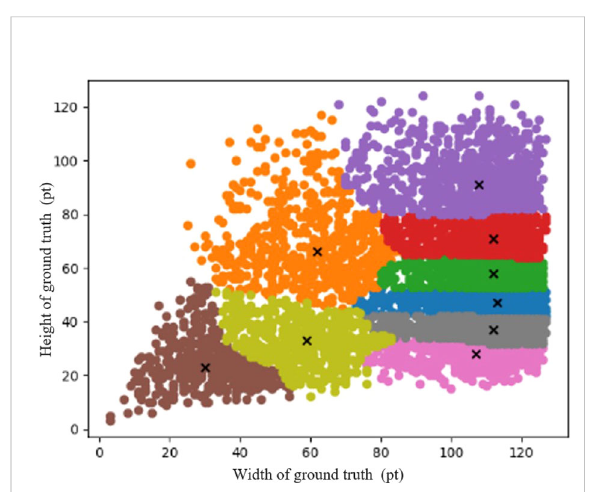
ALGORITHM 1 Pseudocode of K-means clustering algorithm for anchor boxes.